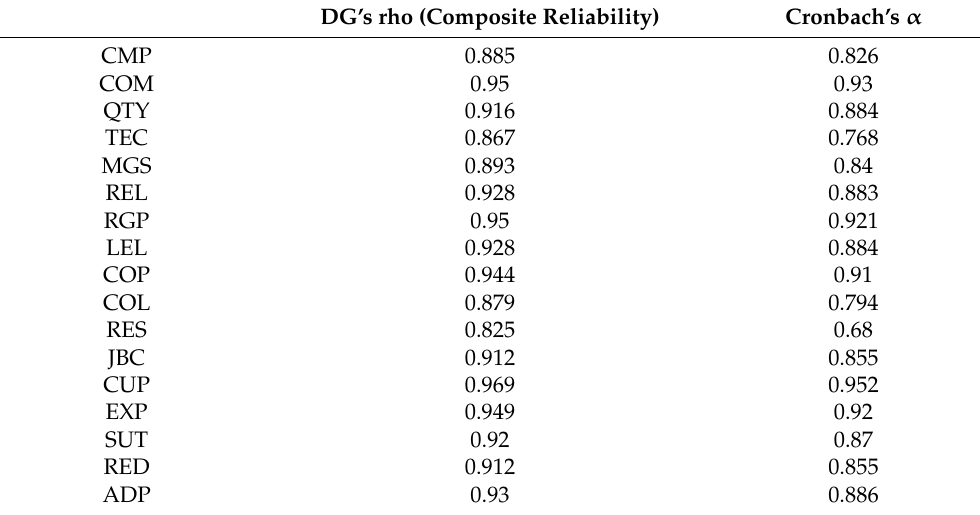
Table 4. Reliability analysis.